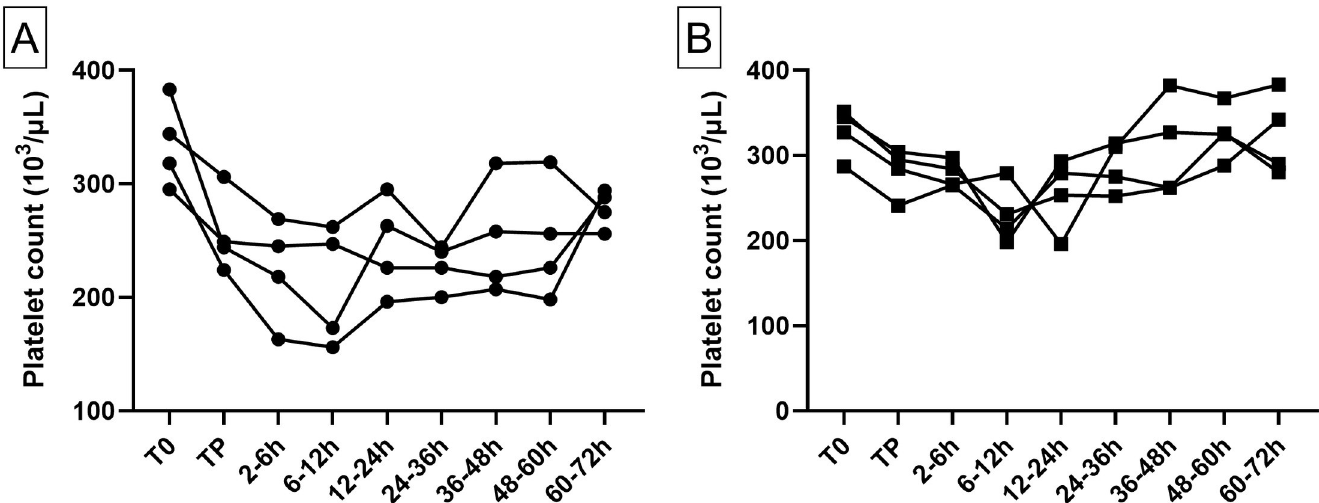
Fig 5. Animal platelet counts in the visceral model (A, n = 4) and the cardiac model (B, n = 4). Each line represents one animal. The different times of sampling are during anesthesia before blood loss (T0), after autologous transfusion at the end of anesthesia (TP), then during the 72 h survival follow-up period (7 sampling times following the end of the transfusion). One animal in the visceral model was excluded for the platelet count due to platelet aggregation verified on the blood smear and failure of the hematological analyzer.